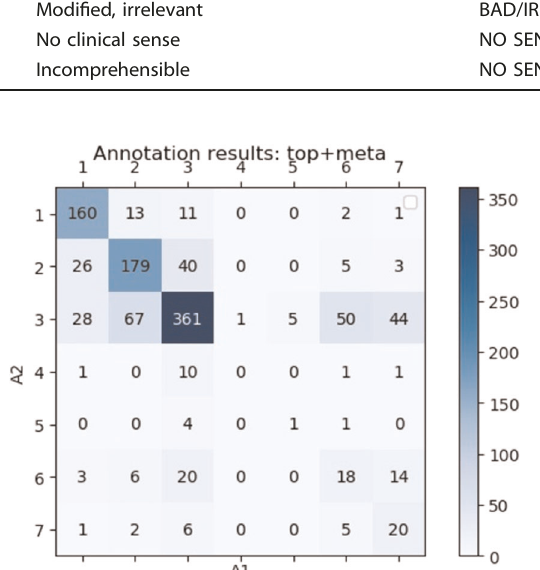
Fig. 4 Matrix of inter-rater annotation agreement for 1K top + meta sentences. For each document, we de fi ned A1 as the fi rst annotator and A2 as the second annotator. Each cell in the matrix represents the number of sentences marked by an annotator with a certain category (as de fi ned in Table